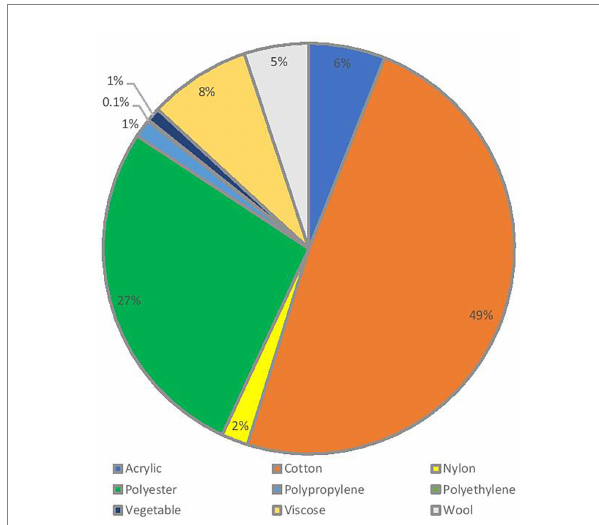
FIGURE 4 Percentage composition of fibres recovered across the 37 sampled locations.